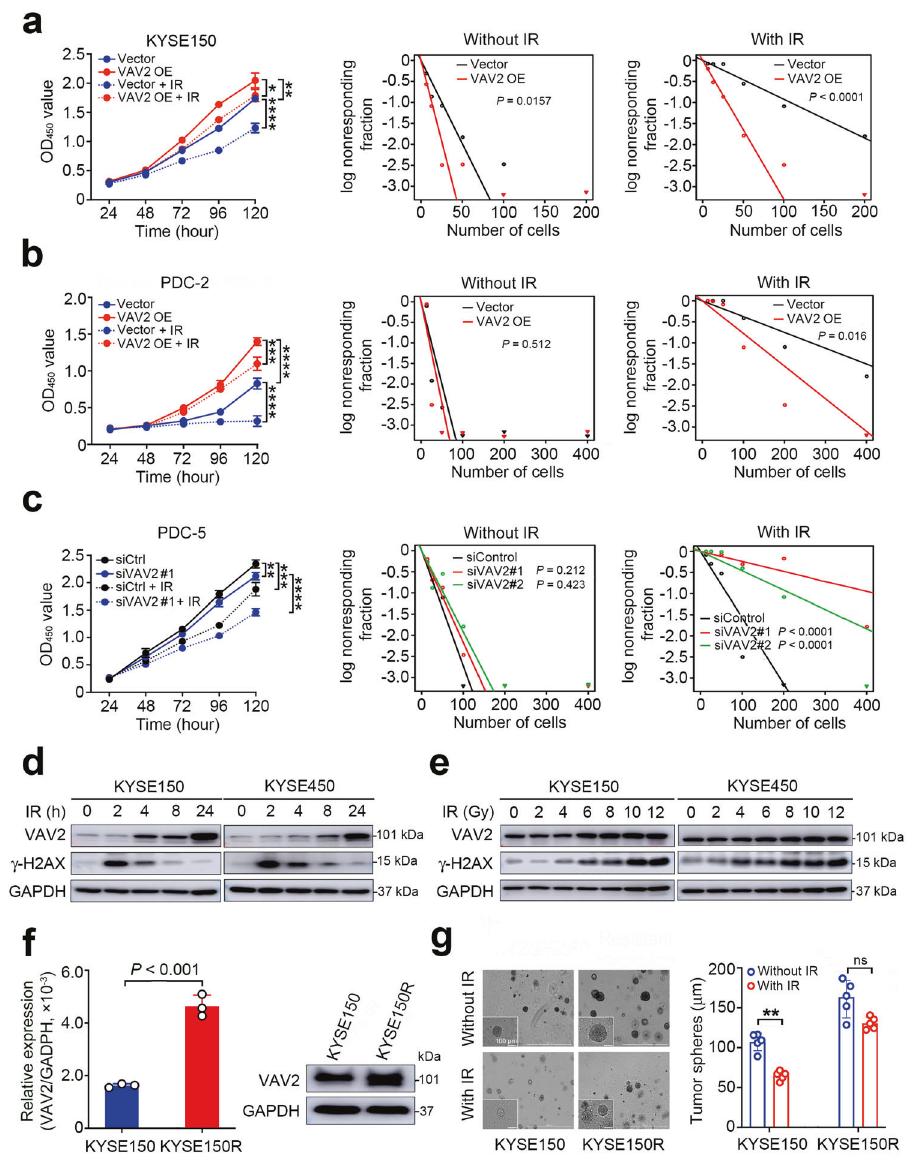
Fig. 2 Irradiation induces ESCC cell radioresistance by evoking aberrant VAV2 overexpression. a , b Forced VAV2 overexpression in KYSE150 cells ( a ) or radiosensitive PDC-2 cells ( b ) caused resistance of cells to IR treatment. Left panels show proliferation curves of cells and right panels shows fractions of cell survival by limiting dilution assays. IR, irradiation (4 Gy). c Silencing VAV2 expression by siRNA in radioresistant PDC-5 cells signi fi cantly increased sensitivity of cells to IR treatment. Left panels show proliferation curves of cells with siRNA#1 (the results of siRNA#2 are shown in Supplementary Fig. S2g); middle and right panels show fractions of cell survival by limiting dilution assays. IR, irradiation (4 Gy). d , e Western blot analysis showed overexpression of VAV2 and γ -H2AX in ESCC cells treated with radiation (10 Gy), which is time- ( d ) and dose- dependent ( e ). f Comparison of VAV2 mRNA ( left panel ) and protein ( right panel ) levels in IR-induced radioresistant KYSE150 cells (KYSE150R) and its parental KYSE150 cells. Results are mean ± SEM from three independent determinations and each had three triplicates. P of Mann – Whitney test. g Tumor spheres of KYSE150 and KYSE150R cells treated with or without radiation (4 Gy). Left panel shows representative images of tumor spheres and right panel shows statistics. Scales bars, 100 μ m. Data are mean ± SEM from at least three independent experiments and fi ve fi elds were randomly selected for each experiment. * P < 0.05; ** P < 0.01; *** P < 0.001 and **** P < 0.0001 of Student ’ s t overexpressing FLAG-VAV2 and anti-FLAG antibody, followed by spontaneous and IR-induced DNA damages compared with mass spectrometry analysis. The results indicated that at least 186 siControl (Fig. 3i and Supplementary Fig. S3k). These results proteins might interact with VAV2 (Supplementary Table S4) and demonstrate that VAV2 plays an important role in DNA repair, among the top 15 ranked by the abundance were X-ray repair which may be the underlying mechanism for radioresistance of cross-complementing protein (XRCC) 6 and 5, also known as Ku70 ESCC having VAV2 overexpression. and Ku80 (Fig. 4a), two proteins function as an obligate Ku70/Ku80 heterodimer in DNA NHEJ repair. 22,23 The interaction of VAV2 with the Ku70/Ku80 complex were con fi rmed by the same immunoprecipitation-coupled proteomics assays using anti-VAV2